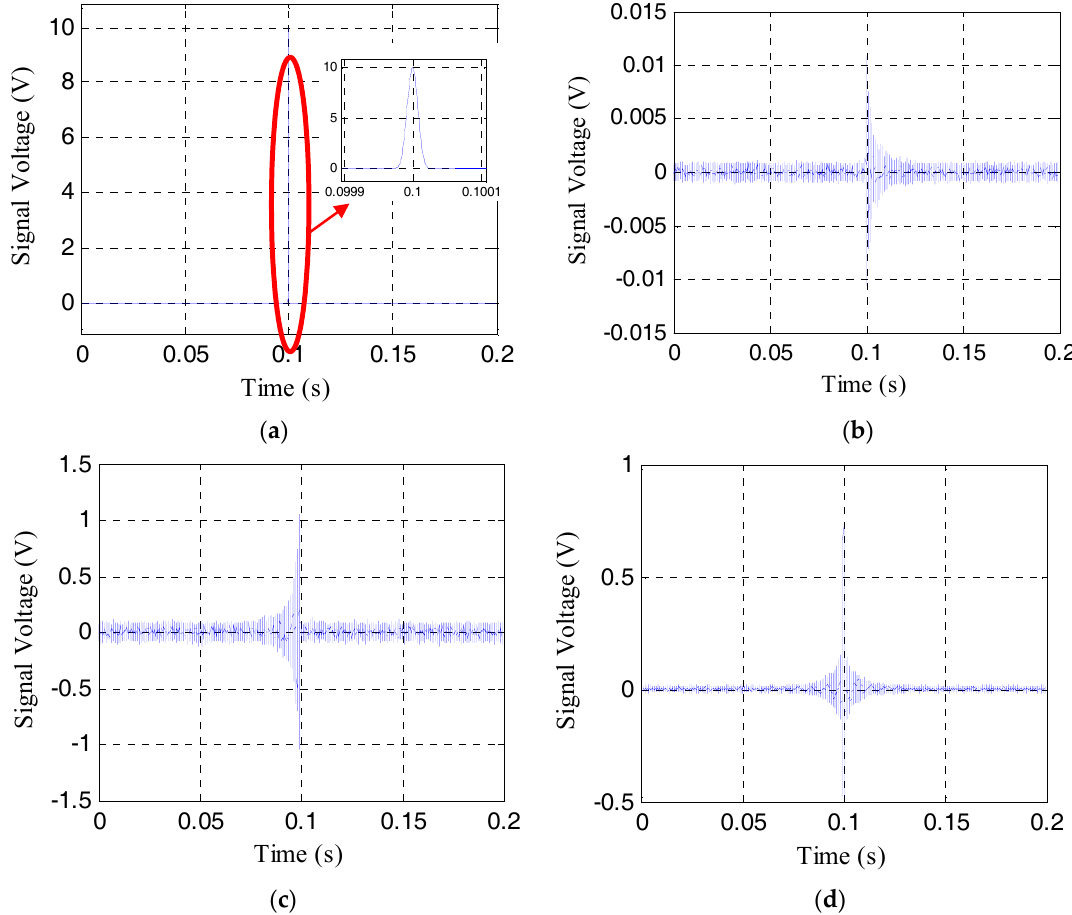
Figure 7. Four different signals in time reverse method at the pre-load of 9 MPa. ( a ) The emitted signal; ( b ) the received signal; ( c ) the reversed signal; ( d ) the focused signal.